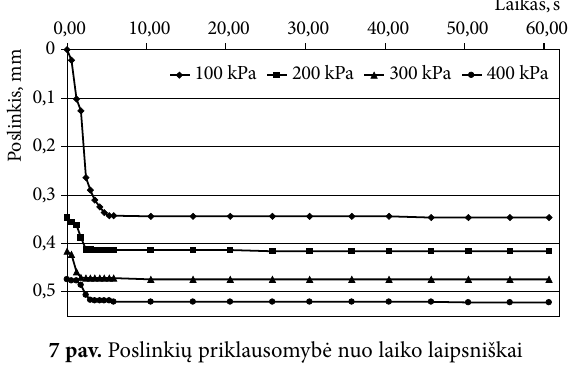
7 pav. Poslinkių priklausomybė nuo laiko laipsniškai Fig. 7. Displacement versus load increments